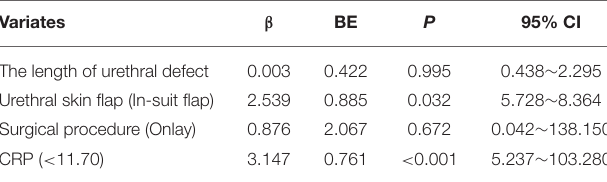
TABLE 2 | The result of binary logistic regression